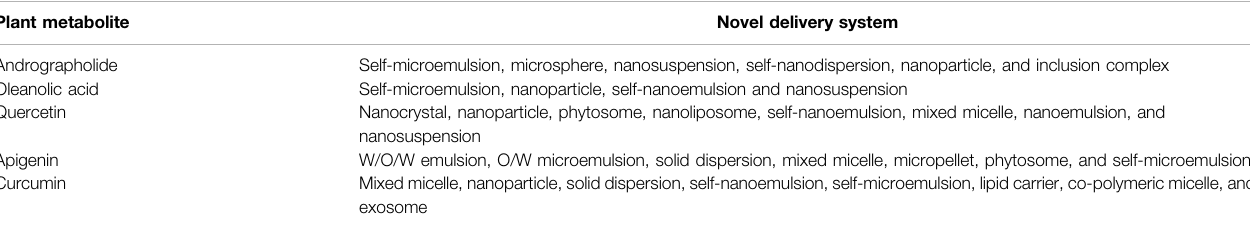
TABLE 5 | Effective delivery systems for oral delivery of plant metabolites with antiviral activity (Ben-Shabat et al., 2020). Plant